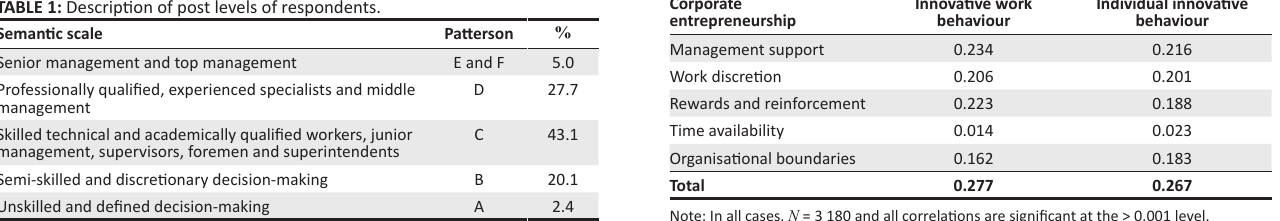
TABLE 1: Description of post levels of respondents. Semantic